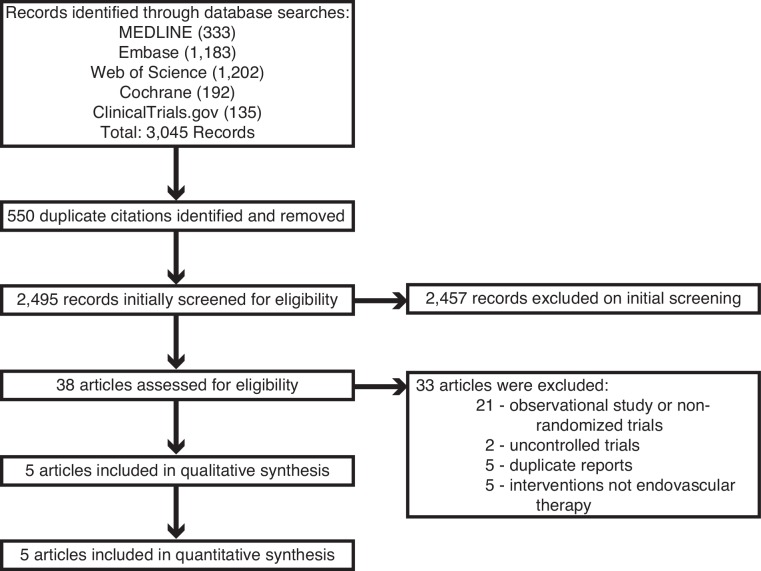
Flow selection of randomized controlled trials included in the meta-analysis.